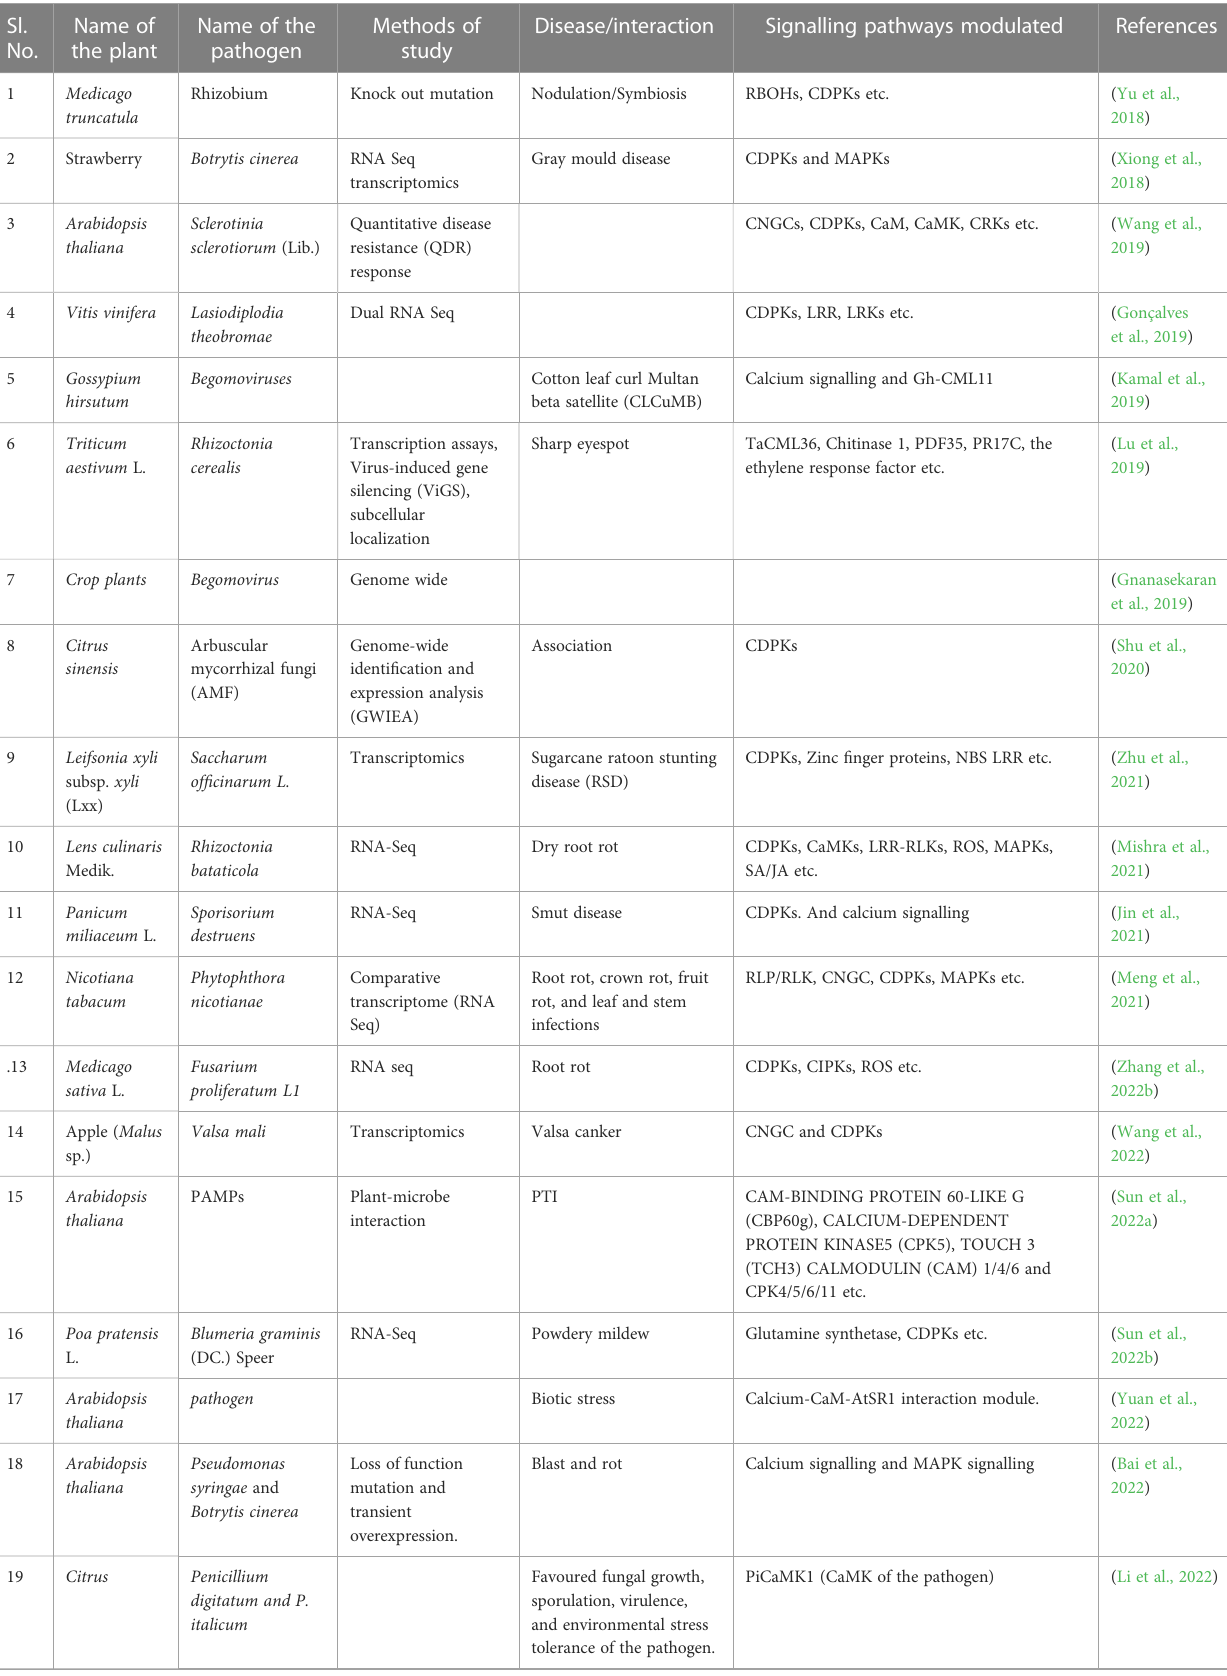
TABLE 1 A list of plant-microbe interaction studies revealing calcium signalling plays a crucial role. Sl.